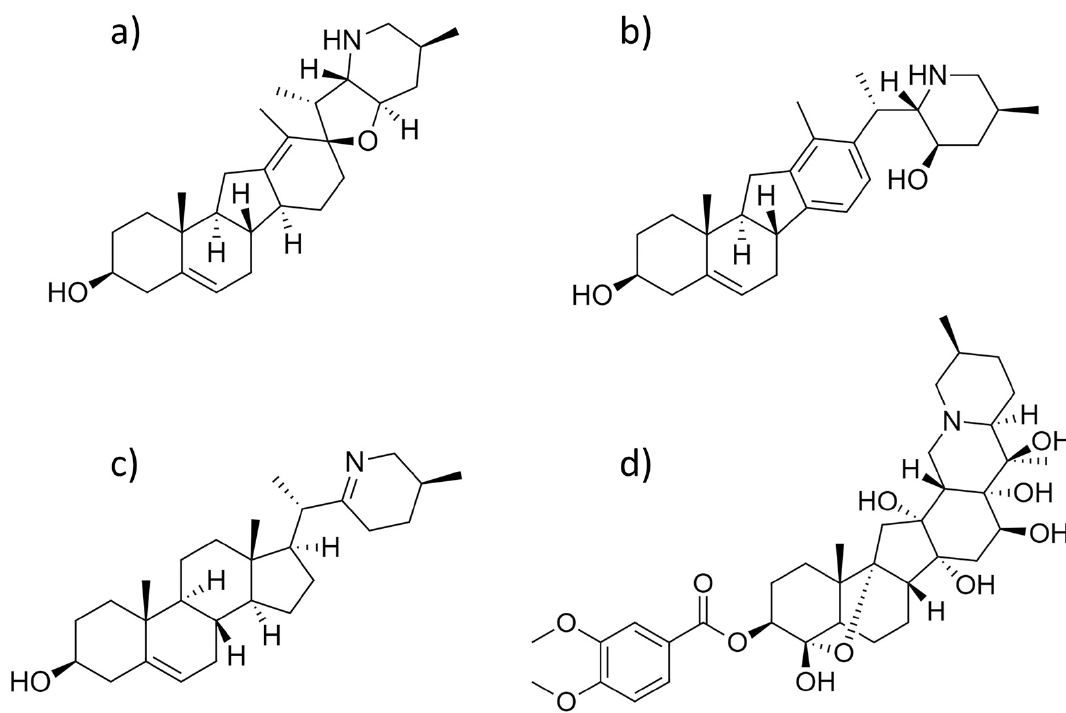
Figure 4. Chemical structures of ( a ) cyclopamine, ( b ) veratramine, ( c ) verazine, and ( d ) veratridine.